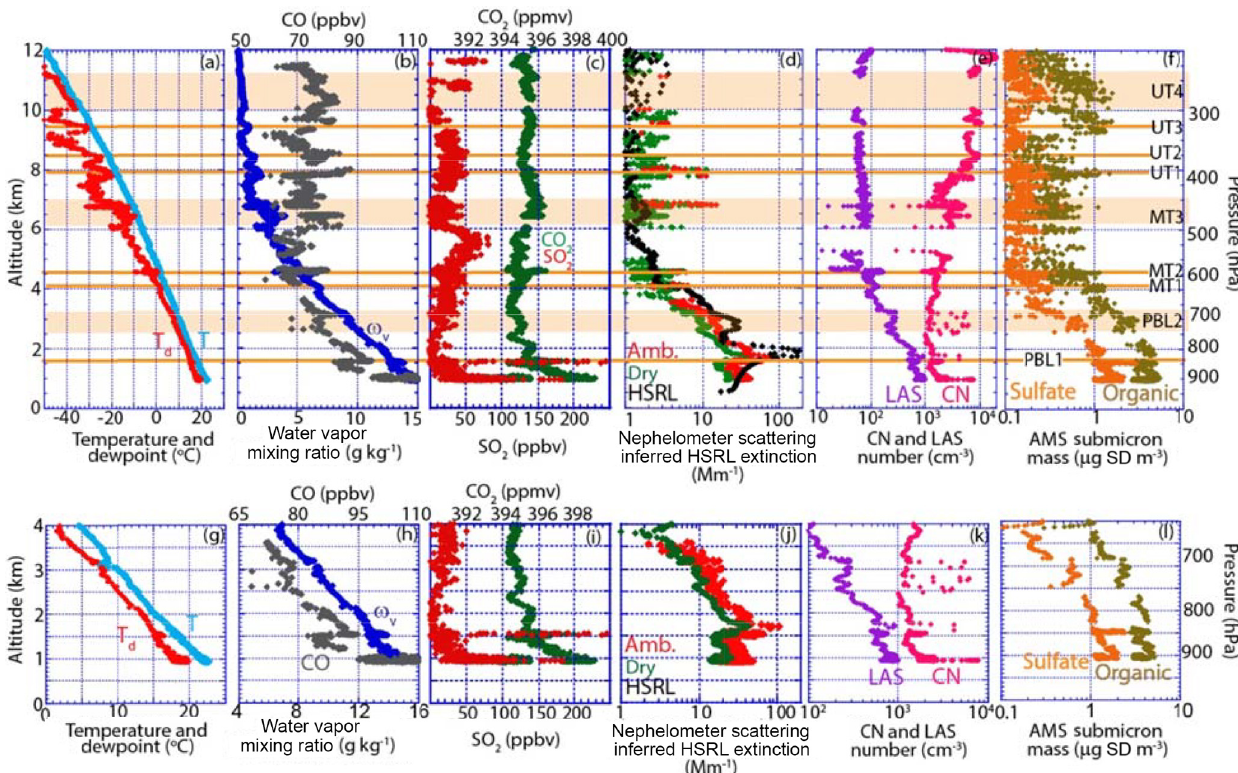
Figure 6. DC-8 aircraft spiral sounding data initiated on 12 August 2013 at 19:10:30UTC on the downwind side of a thunderstorm over northwest Alabama. Altitudes are relative to mean sea level, ∼ 300m higher than a.g.l. Included is (a) temperature and dew point; (b) water vapor mixing ratio ( ω v ) and CO; (c) CO 2 and SO 2 ; (d) DC-8 total ambient and a fine dry 550nm nephelometer with the ground-based UW-HSRL-derived extinction (lidar ratio = 55sr − 1 ) at Huntsville Al; (e) number concentration from laser aerosol spectrometer (LAS, d p > 0 . 1µm) and condensation nuclei (CN, d p > 10nm); (f) aerosol mass spectrometer organic materials and sulfate. Key moisture and aerosol layers as discussed in the text are marked as orange lines or bands. (g–f) same as (a–e) expanded in the vertical to enhance PBL feature readability, and the legends are